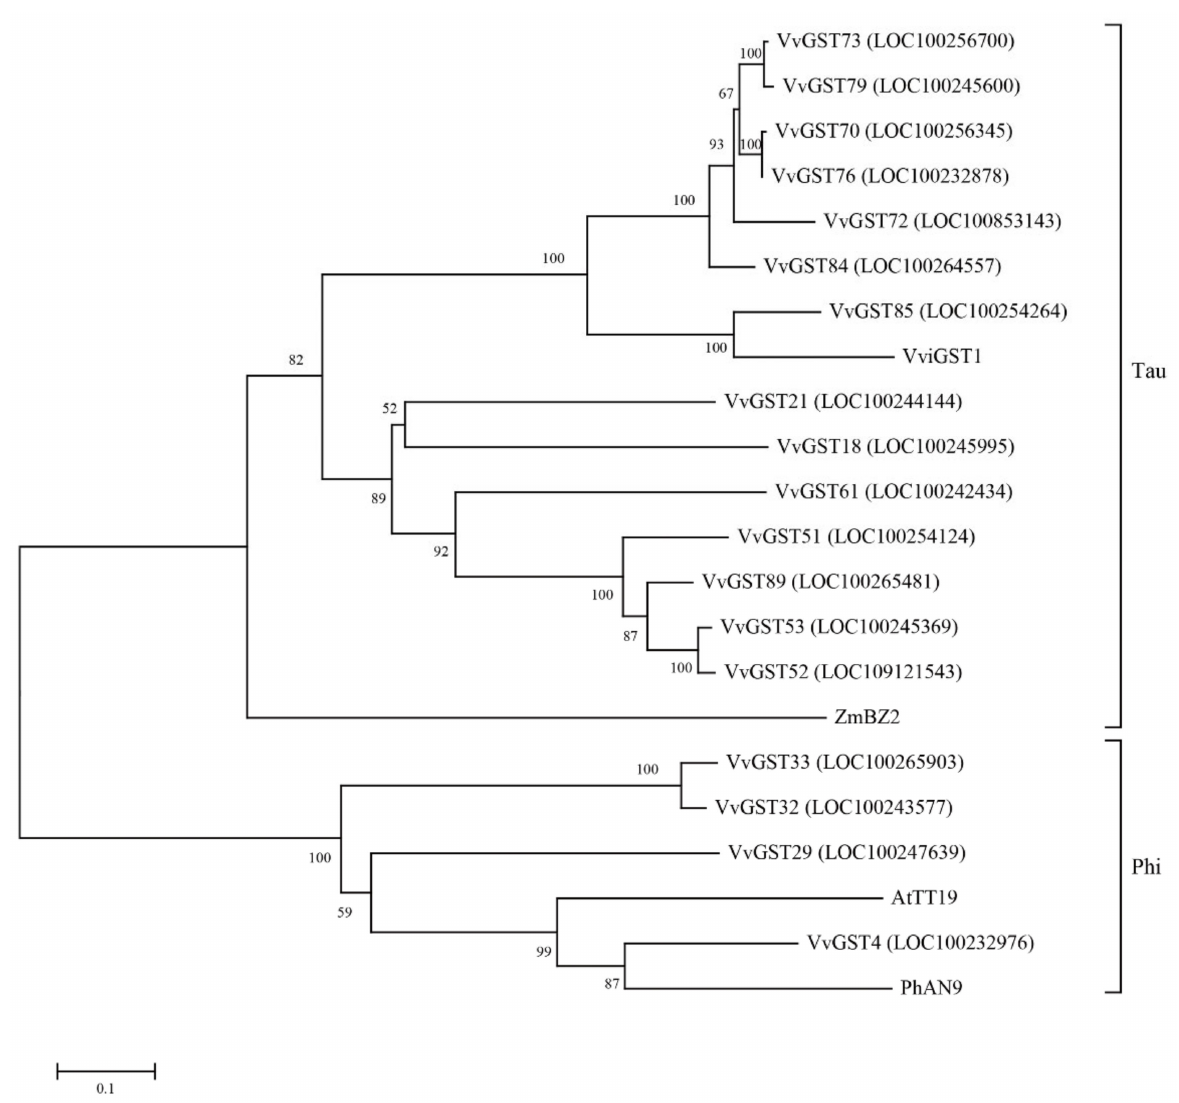
Figure 9. Phylogenetic relationship between 18 GST genes and the PhAN9, AtTT19, ZmBZ2 and VviGST1 proteins. The tree was constructed according to the neighbor-joining method in MEGA X, and the Poisson model, partial deletion and 1000 bootstrap replicates were